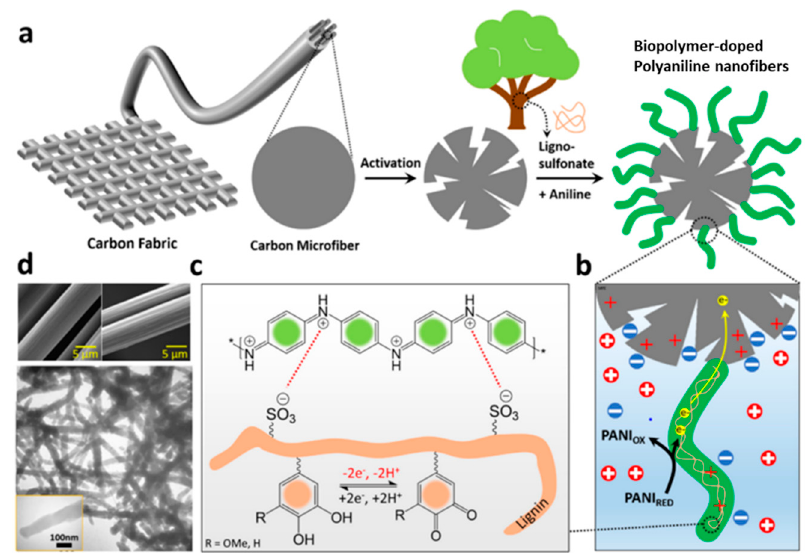
Figure 10. ( a ) Schematic representation of electrochemical etching of a carbon microfiber under a constant potential of +2.0 V for 180 s in 0.5 M H 2 SO 4 and subsequent electro-polymerization of aniline in the presence of lignosulfonate chains on the electrochemically etched carbon fiber substrate. ( b ) Faradaic charge transfer and electrical double-layer charge accumulation at the electrode–electrolyte interface. ( c ) Electrochemical activity of lignosulfonate moieties as dopants and structure-directing agents for PANI films, and the redox activity of lignosulfonate (forming catechol moieties) in PANI/lignin nanocomposites. ( d ) (top) SEM images of the carbon fiber substrate (left) before and (right) after electrochemical etching; (bottom) TEM image of the resulting PANI/lignin nanocomposite. Reprinted with permission from ref. [54] Copyright 2021 American Chemical Society.